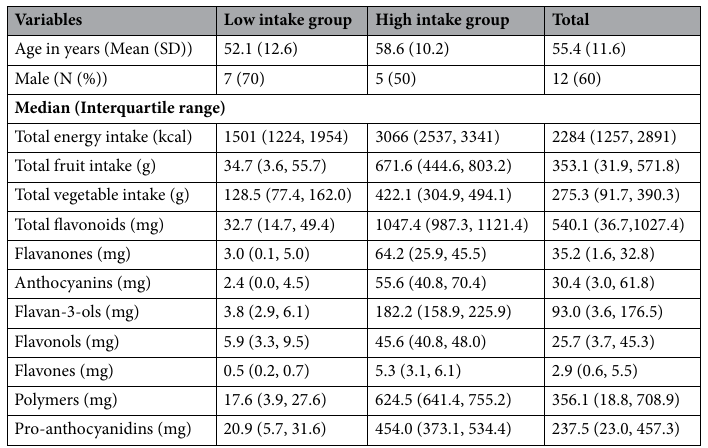
Table 1. General characteristics and dietary intake in participants with low and high intakes of